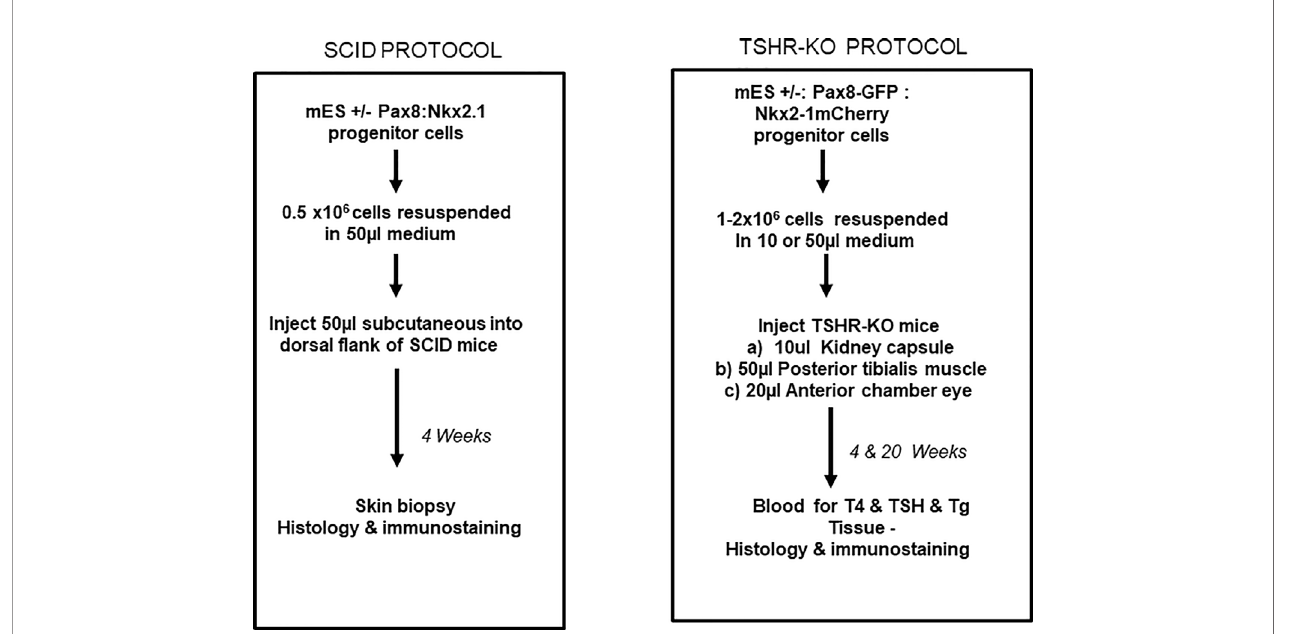
FIGURE 5 | Transplantation protocols. Flow charts detailing the protocol used for the transplantation of the differentiated cells into either the SCID mice or into the TSHRO mice kidney/muscle/eye implantation